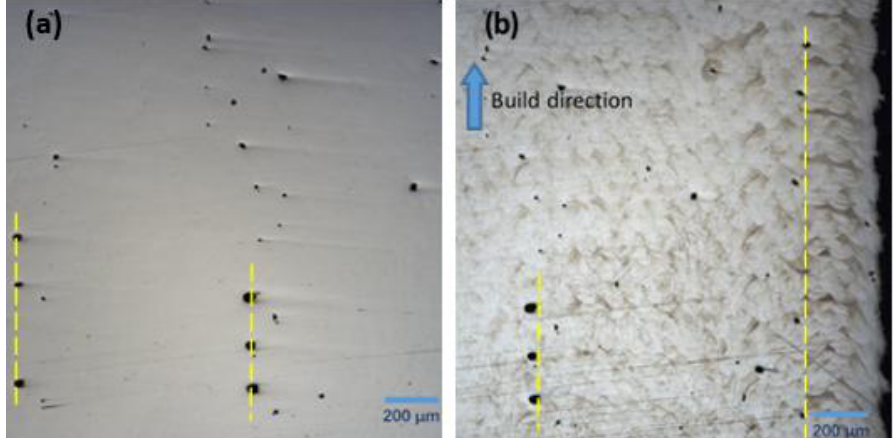
Figure 6. Aligned pores at successive solidified layers for: ( a ) un-etched and ( b ) etched specimens cut along the x – z plane. Similar results were observed for specimens in the y – z plane.